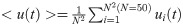
Robustness of artificial spiral wave to defects.(a) (b) Trajectories of <u(t)>=1N2∑i=1N2(N=50)ui(t) ((a)) and the spatiotemporal pattern ((b)) obtained as the 2 × 2 square defect (denoted by the red region in (b)) outside the 1D Winfree-loop is introduced at t = 4.5 (indicated by the dot line in (a)). The spatiotemporal pattern shown in Fig 6(d) is used as the initial condition for artificial spiral wave. In present paper, defects are introduced by discarding all connections between nodes in defect region and outside defect region. Artificial spiral wave is robust to the defect outside the oscillation source. (c) (d) The same as (a) and (b) when the defect is introduced on the 1D Winfree-loop. As the defect on the source loop is introduced, < u(t) > damps to zero gradually. The spatiotemporal pattern shown in (d) is obtained at t = 45, where the artificial spiral wave approaches homogeneous rest state. The artificial spiral wave degenerates as the oscillation source is destroyed.